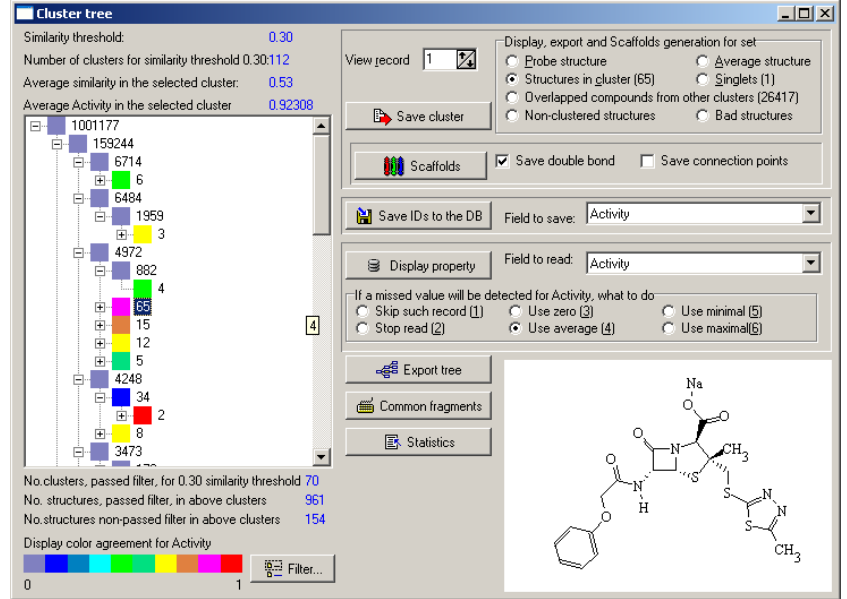
Figure 5. Implementation of Representative filter for TESTDB clusters tree